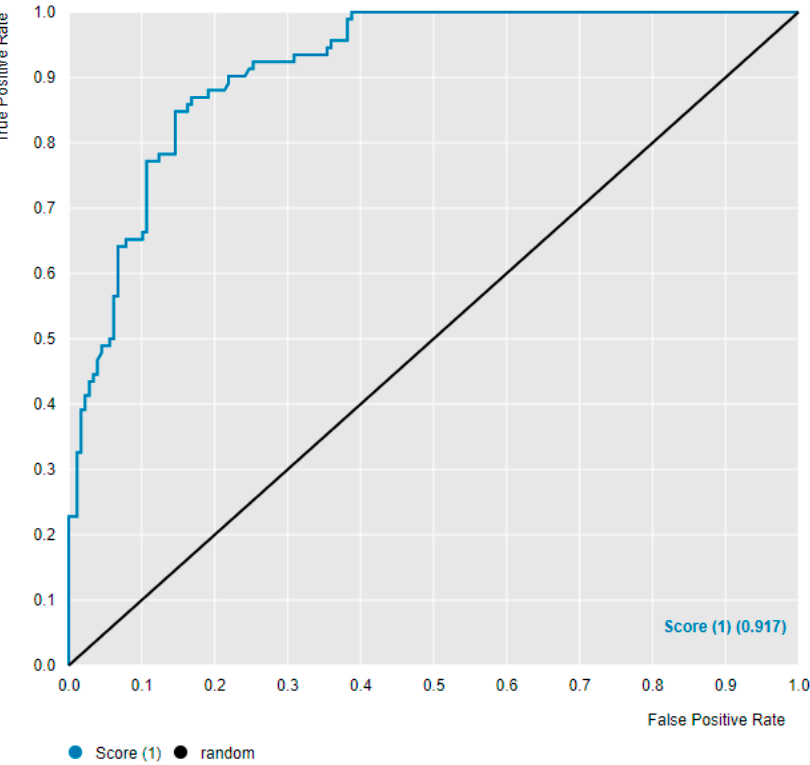
Figure 4. ROC for the NBN trained on the ALK dataset with a < 20 nM classification.